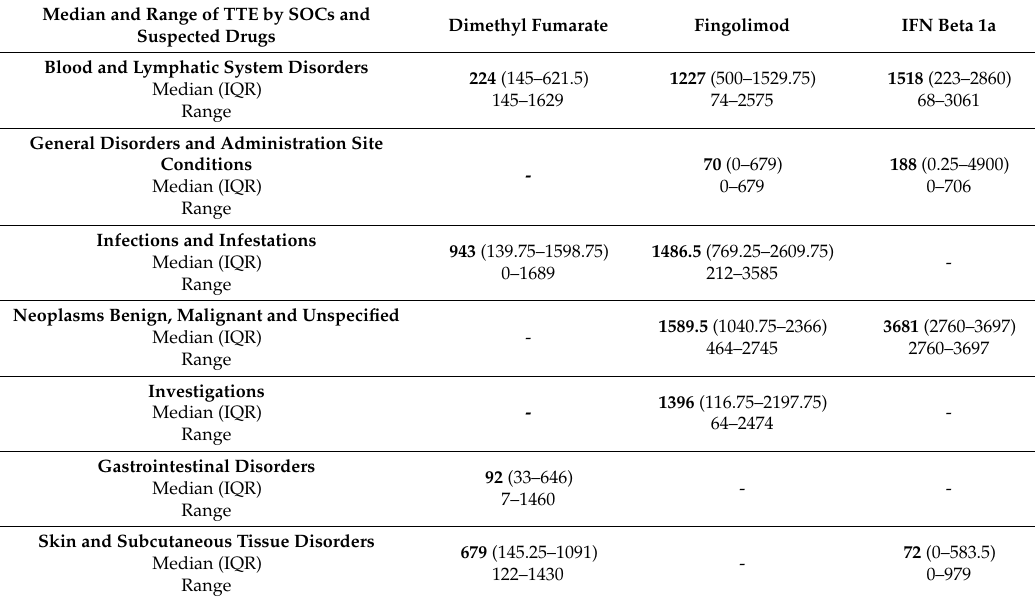
Table 4. Median (IQR) and range of Time to Event (days) for dimethyl fumarate, fingolimod and IFN beta 1a and most common reported System Organ